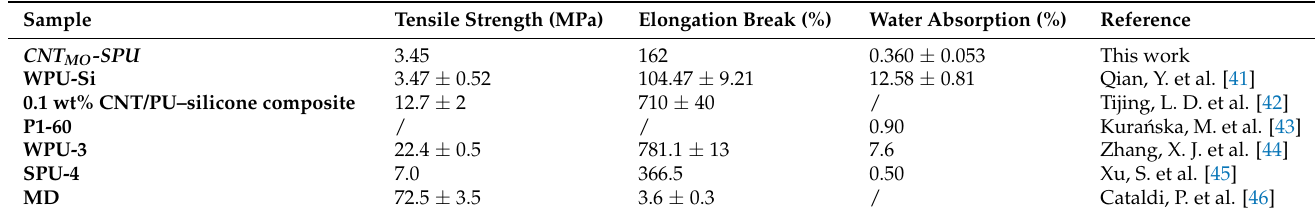
Table 2. Summary of mechanical properties and water absorption of SPU.